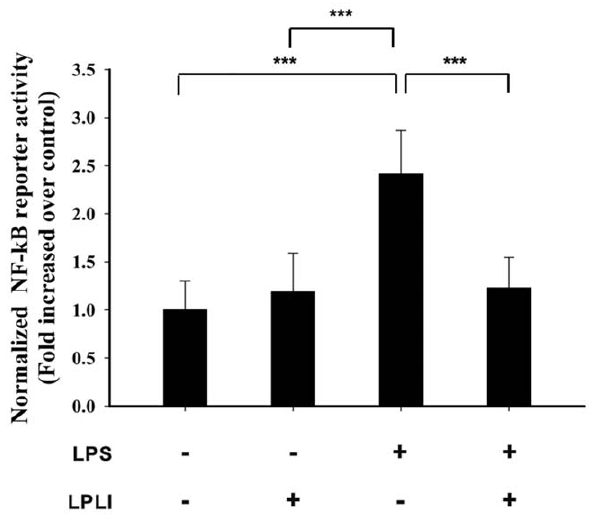
Figure 6. LPLI decreases the transcription activity of NF k B. hADSCs were transfected with the vectors pGL-NF k B and pTK-Renilla (control vector), and the cells were then incubated with 50 ng/ml LPS with or without LPLI. Luciferase activity was assayed 5 hours after LPLI treatment. The data are expressed as the mean 6 SD of 3 independent experiments. The statistical level applied was ***p ,